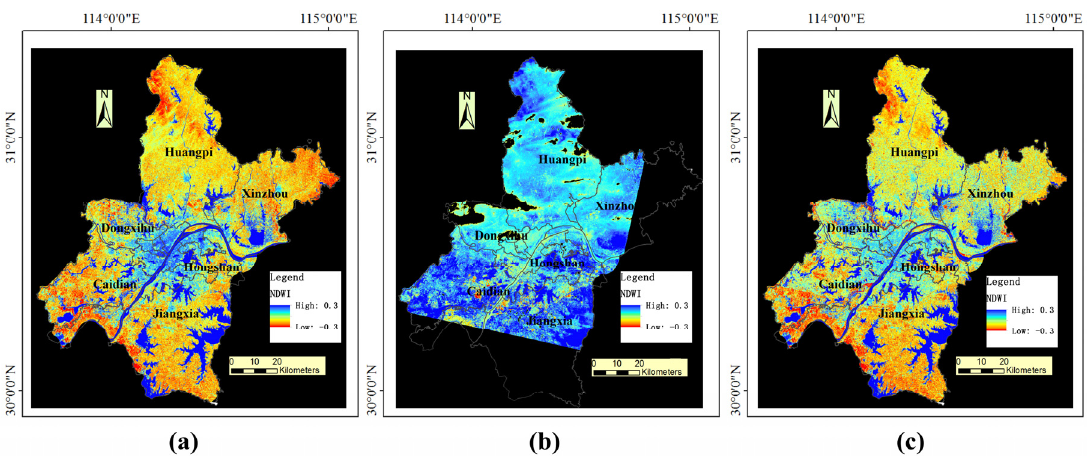
Figure 9. GF-1 waterlog NDWI distributions in Wuhan city during periods of torrential rainfall: 31 March 2015 ( a ), 3 April 2015 ( b ) and 10 April 2015 ( c